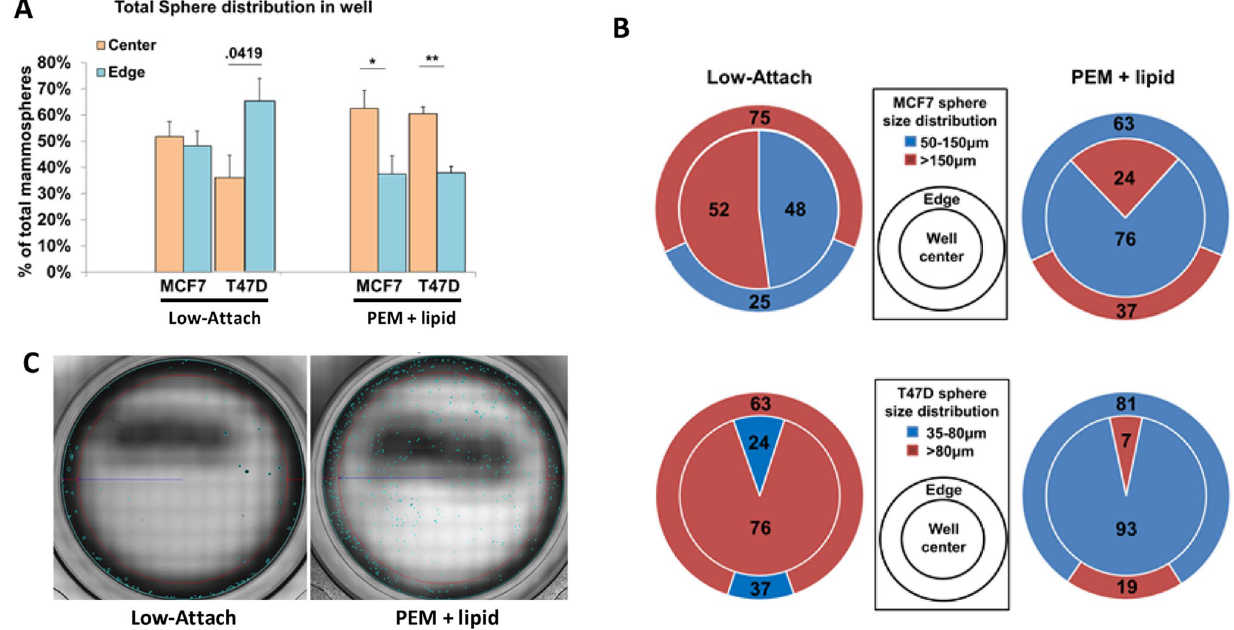
Figure 3. Lipid tethering reduces the effects of aggregation: single cell suspensions of MCF7 and T47D cells were used to seed 1000 cells into low attach and PEM + lipid coated well plates and were analyzed on Day 7 post-seeding. ( A ) Low attachment wells have no significant difference in distribution of mammospheres in the well center and at the well edge for either MCF7 or T47D cells, whereas lipid coated wells have a significant difference of > 20% between spheres in the center and edges of the well in both cell lines. ( B ) Panel ( B ) is a visual representation of sphere size distribution in the wells. Edge size distribution at the edge is displayed in the outer ring. Well center distribution is displayed in the inner circle. Values are in percentages. ( B , upper) Low attach plates have a nearly equal size distribution in the center of the well, with the edge having a 75% (± SD6) population of spheres over 150 μm. PEM + lipid wells have only 36% (± SD4) spheres over 150 μm at the well edge and 24% (± SD3) in the center. ( B , lower) Representative images of T47Ds greater propensity to form aggregations, low attach plates have higher concentrations of spheres > 80 μm in both the well center and well edge. PEM + lipid plates however have 93% and 81% clonal spheres in the center and at the edge, respectively. (Statistics formulated using ANOVA with post-hoc Tukey HSD. *p value < .01, **p < .001) C) Representative images of wells seeded with 1000, T47D cells in either low attach or PEM + lipid plates and imaged on day 7. Red circle marks 500 μm from the well